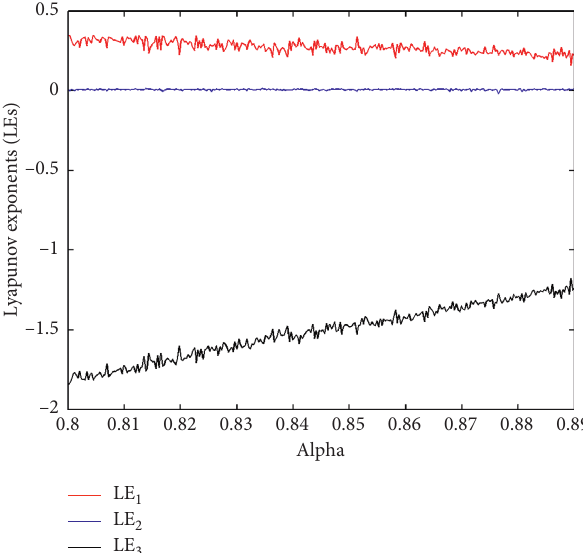
Figure 3: Lyapunov spectrum of FOS model (20) as the parameter α ∈ [ 0 . 8 , 0 . 9 ) with setting a � 0 . 4 , b � 0 . 175 , and c � 0 .